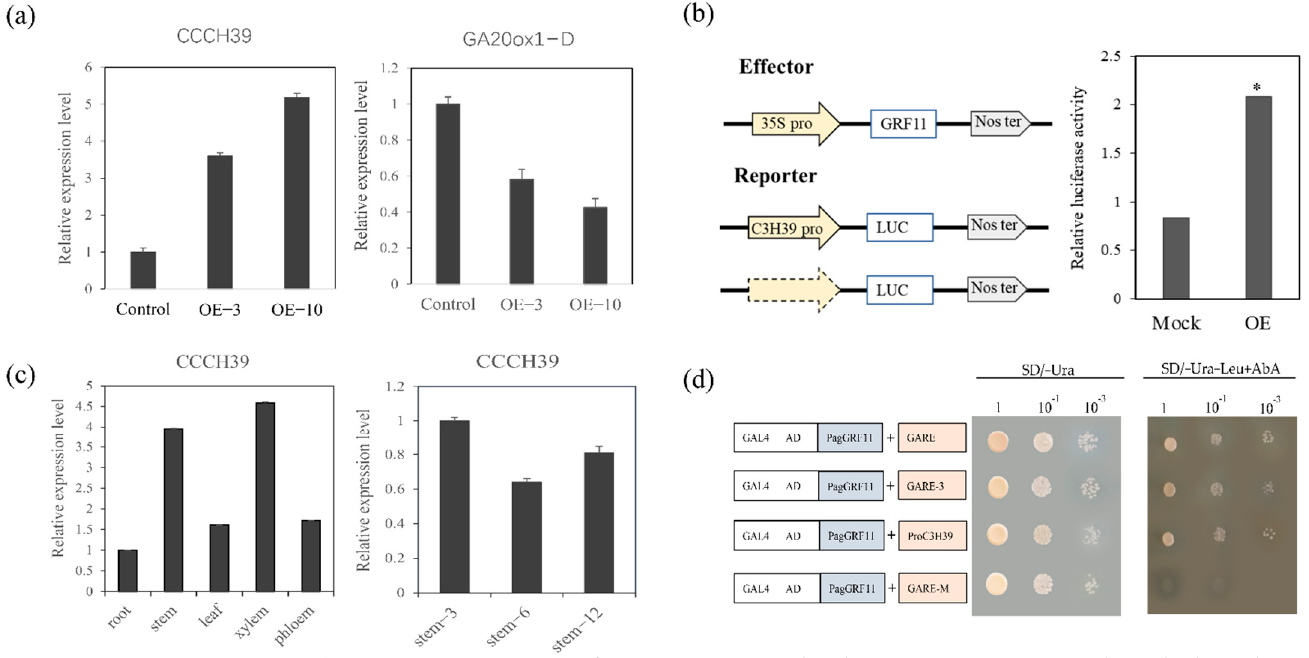
Figure 6. Overexpression of PagGRF11 up-regulated CCCH39 expression and resulted in plant dwarfing and increased lignin. ( a ) Expression level analysis of CCCH39 and GA20ox1-D in PagGRF- OE and control. OE-3: PagGRF11-OE-3 , OE-10: PagGRF11-OE-10 . ( b ) Dual-luciferase assay showing the increase of CCCH39 by the PagGRF11 effector construct compared to the control effector con- struct. Effect: Effect vectors; Reporter:Report vector. Mock: Effectors co-transform tobacco with empty reporters; OE: Effectors co-transform tobacco with C3H39 pro reporters. * denotes p = 0.0001. ( c ) Analysis of expression patterns of CCCH39 in different tissues. ( d ) Yeast single hybrid confirmed that PagGRF11 could directly activate the expression of CCCH39 . Four yeast reporters were con- structed: GARE (TCTGTTG), GARE-3 (TCTGTTCTCTGTTGTCTGTTG), ProC3H39 ( CCCH39 pro- moter sequence length 533 bp), GARE-M (TCCCCCC), and the PagGRF11-AD fusion expression vector was co-transfected into yeast respectively. Growth on SD/-Ura and SD/-Ura-Leu+AbA me- dium .